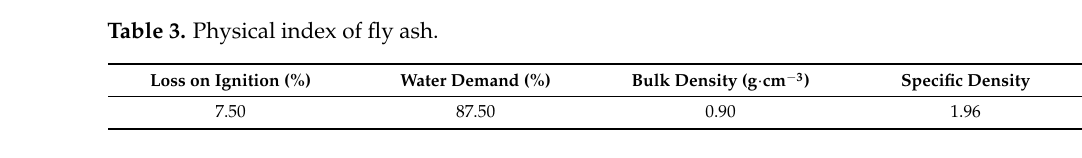
Table 4. Physical index of basalt